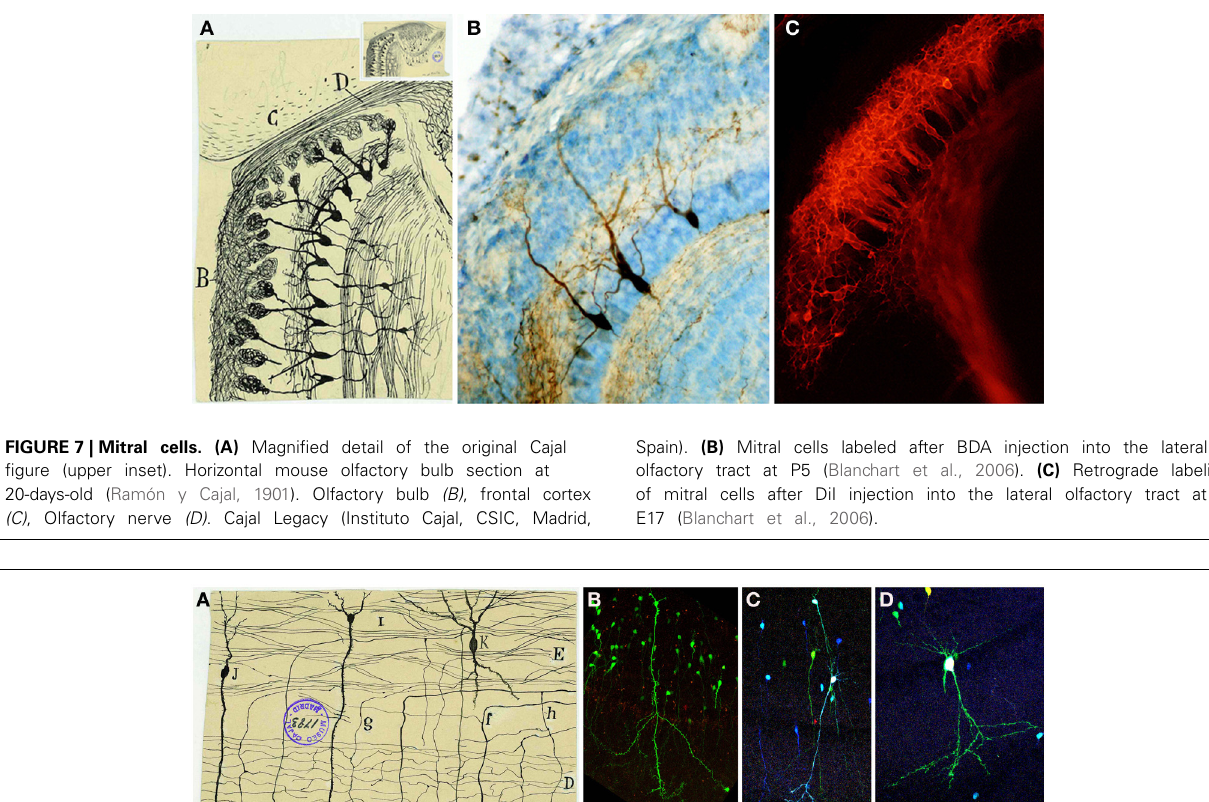
FIGURE 8 | Granular cells. (A) Original Cajal drawing of an olfactory bulb section from a few days cat brain (Ramón y Cajal, 1901). G lomerular layer (A) , outer plexiform layer (B) , mitral cell layer (C) , inner plexiform layer (D) , grains layer and white matter (E) . (a) Terminal arborization of an olfactory fiber; (b) glomerulus with several endings; (c) mitral plume; (d) tufted cells. Cajal Legacy (Instituto Cajal,